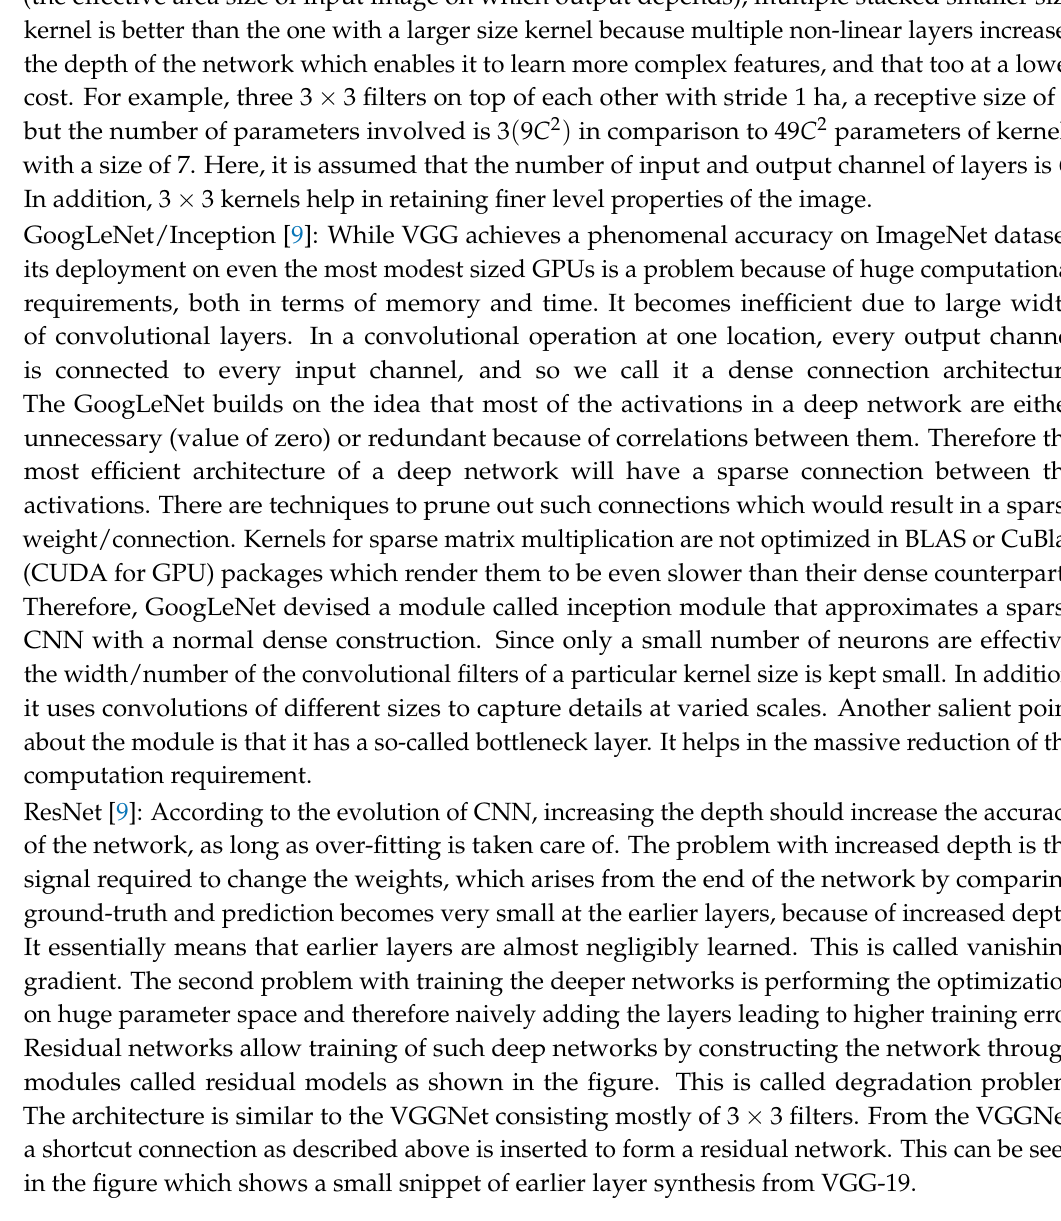
Table 1. Convolutional neural networks architectures evolution (The top-1 accuracy rate is the ratio of images whose ground truth category is exactly the prediction category with maximum probability, while the top-5 accuracy rate indicates the ratio of images whose ground-truth category is within the top-5 prediction categories sorted by the probabilities, accuracy is obtained using ImageNet